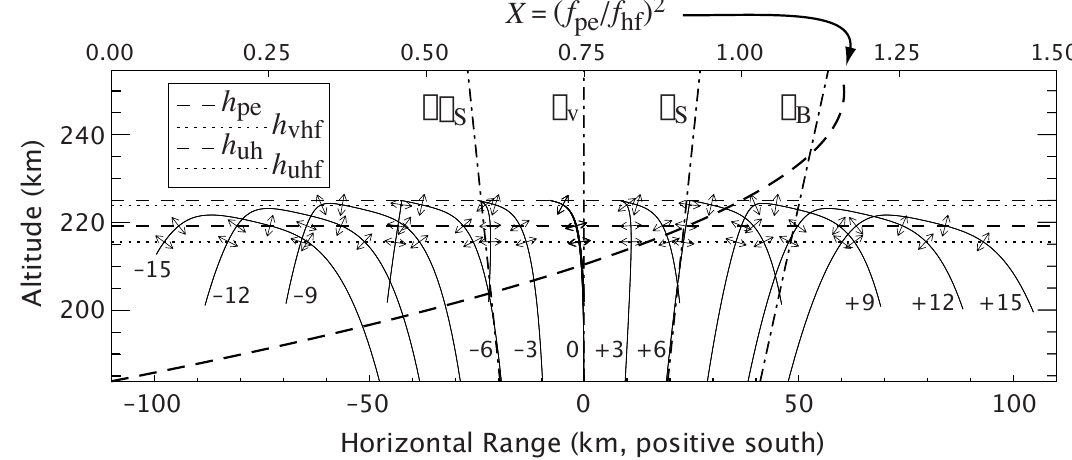
Fig. 15. Computed ray paths and electric field polarizations of an RF pump wave in a smooth ionosphere at the EISCAT VHF radar matching height ( h vhf ) , the upper-hybrid resonance height ( h uh ) , and the EISCAT UHF radar matching height ( h uhf ) . The ray paths are shown for angles between − 15 and + 15 ◦ from vertical ( θ v =0 ◦ ) in the magnetic meridian plane at the EISCAT site near Tromsø, Norway. The plasma density profile is given in units of X =( f pe / f hf ) 2 , where f pe is the cold plasma frequency and f hf is the HF, or RF, pump frequency. The plasma frequency gradient equals 30kHz/km at the critical height ( h pe ) , here chosen to be 225km for an O-mode pump frequency of 4.544MHz. These parameters match those of the data shown in Figs. 2 and 4. A parabolic density profile was assumed, producing an f o F2 of 4.9MHz at 250km altitude. The electron gyroharmonic frequency is 1.33MHz and the geomagnetic field angle ( θ B ) is 12.9 ◦ from vertical. The Spitze angle ( θ S ) is then 6.1 ◦ . The matching heights were computed assuming an electron temperature of 2000K. As the electron temperature decreases the matching heights rise; at an electron temperature of 1050K the VHF matching height would lie about 30% closer to the critical level and the UHF matching height would coincide with the upper-hybrid resonance